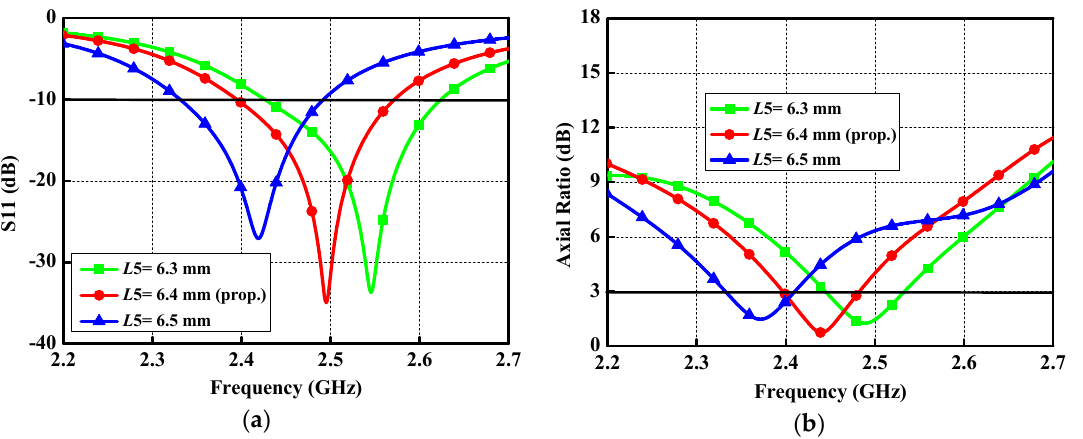
Figure 10. Performance of the proposed antenna with different L 4 values: ( a ) Reflection coefficient; and ( b ) AR.